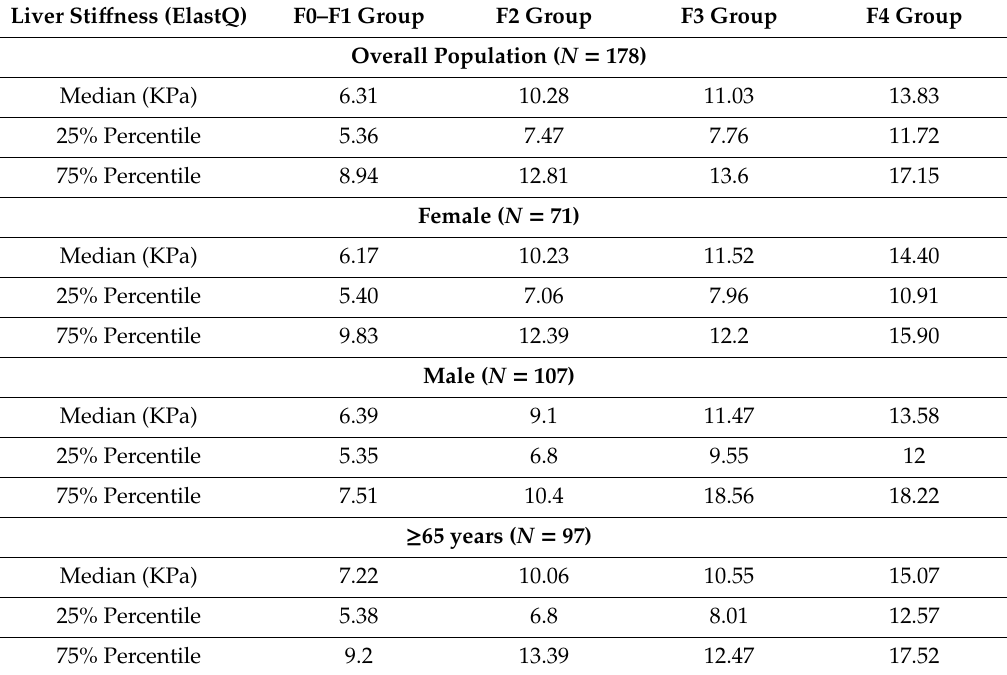
Table 2. Liver Sti ff ness obtained with ElastQ software by subgroups.